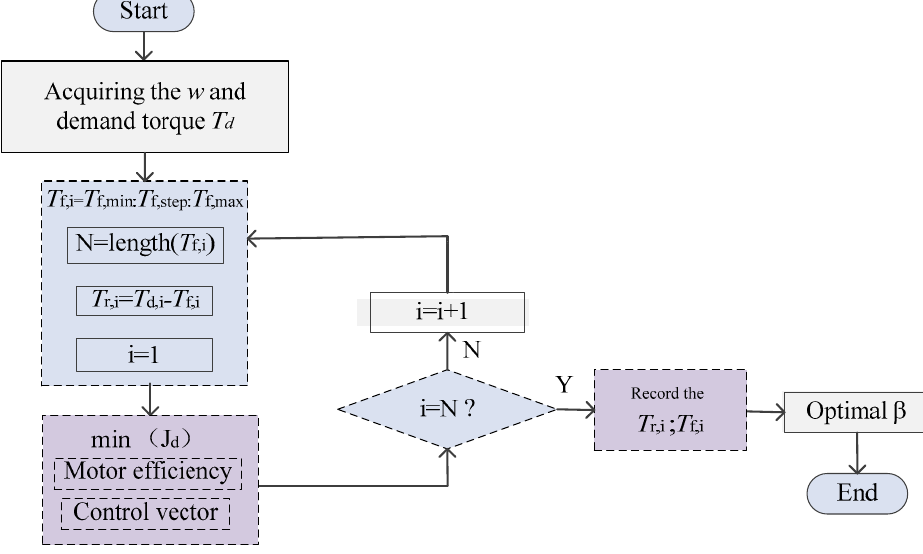
Figure 8. The optimization process of driving torque based on DP.